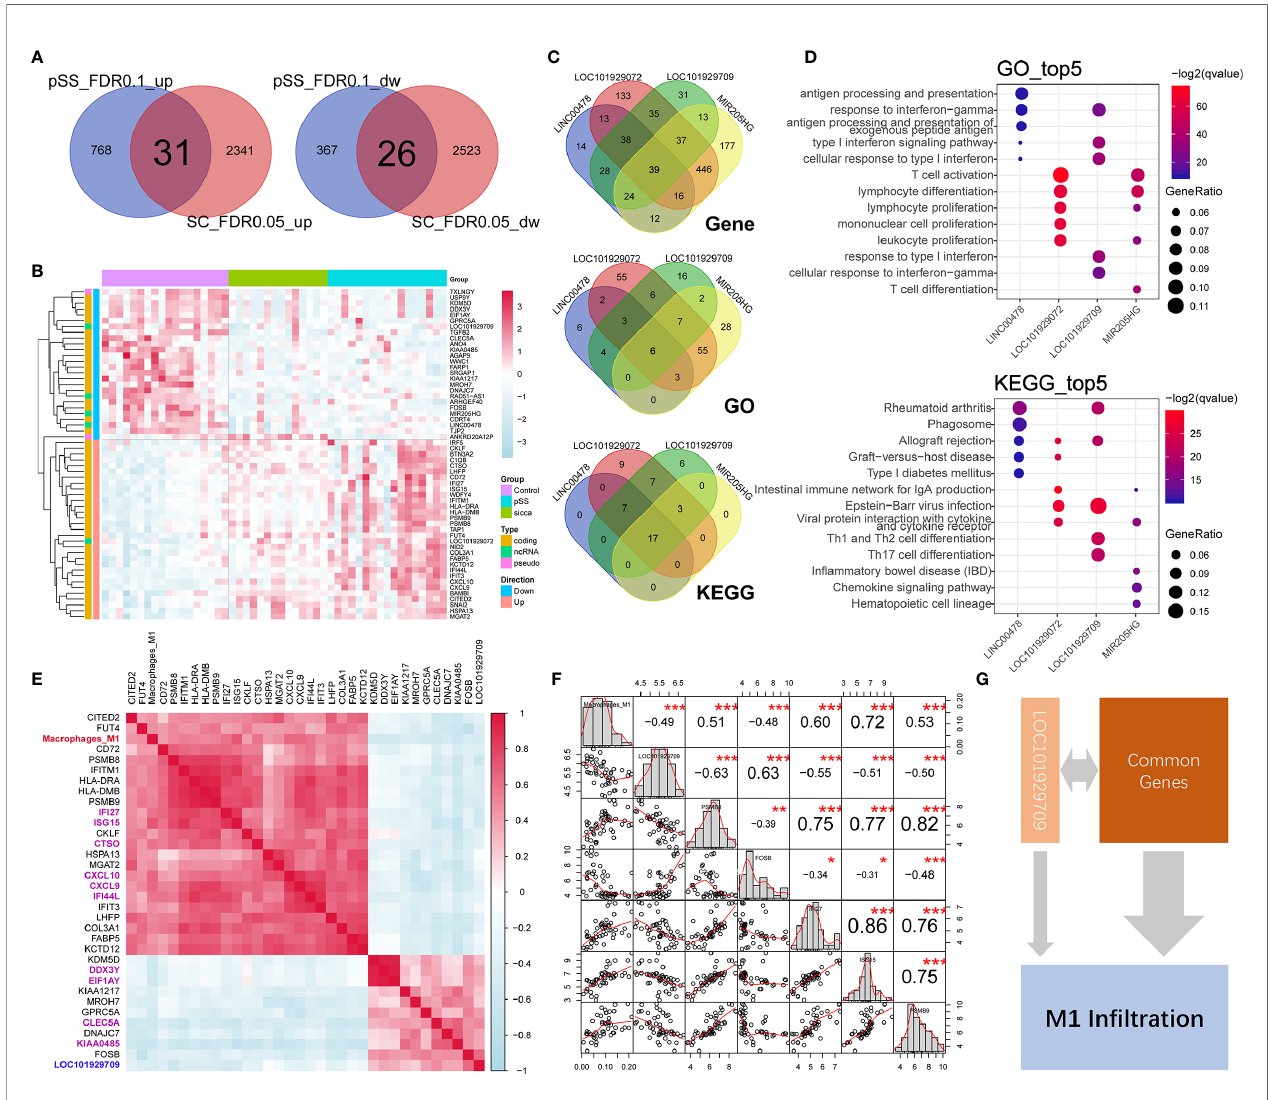
FIGURE 2 | Common genes and lncRNAs associated with the consistent immune-in fi ltration features of “ Sicca ” and pSS. (A) Overlap of up-regulated or downregulated genes in “ Sicca ” and pSS compared to control. A total of 57 genes were identi fi ed as the common genes of the two diseases. (B) Heatmap of 57 common genes shows fi ve lncRNAs, including LINC00478 , LOC101929072 , LOC101929709 , MIR205HG , and RAD51-AS1 . (C) Coexpressed genes and common GO/Kegg items relevant to LINC00478 , LOC101929072 , LOC101929709 , and MIR205HG . (D) Top- fi ve signi fi cant GO and Kegg items of LINC00478 , LOC101929072 , LOC101929709 , and MIR205HG . (E) Correlation of M1 macrophage in fi ltration with common genes and lncRNAs. Heatmap shows the 32 common genes and 1 lncRNA, LOC101929709 (blue) harboring a Pearson correlation coef fi cient larger than 0.4, among which the top-10 signi fi cant genes are labeled in purple color. (F) The M1 macrophage-relevant genes coexpressed with LOC101929709 lncRNA. (G) A model of potential mechanisms of common genes and lncRNAs linked to M1 macrophage in fi ltration in “ Sicca ” and pSS. *P<0.05, **P<0.01,